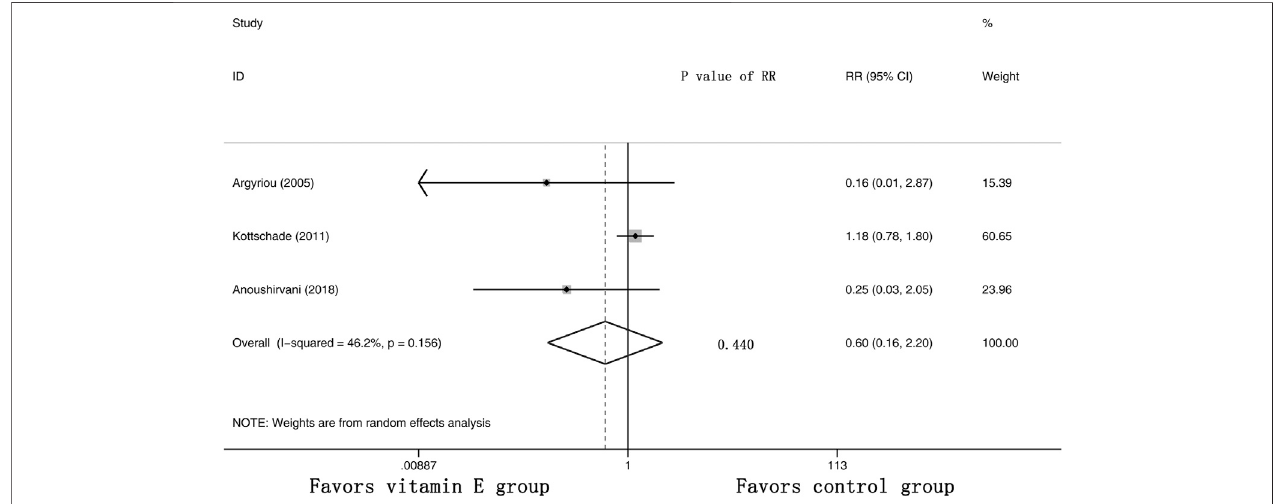
FIGURE 6 | Forest plot of the incidence of severe CIPN in VE and control groups. Summary of the incidence of severe CIPN RR between VE and control groups were calculated using the random effect model. VE, vitamin E; CIPN, chemotherapy-induced peripheral neuropathy; RR, risk ratio; P, p value of the Q test for